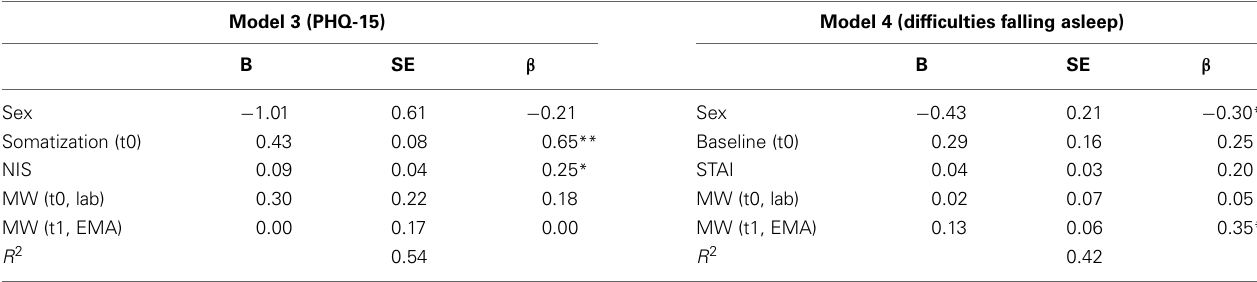
Table 3 | Summary of multiple regression analysis for the prediction of somatization tendencies (Model 3) and difficulties falling asleep (Model 4) at time